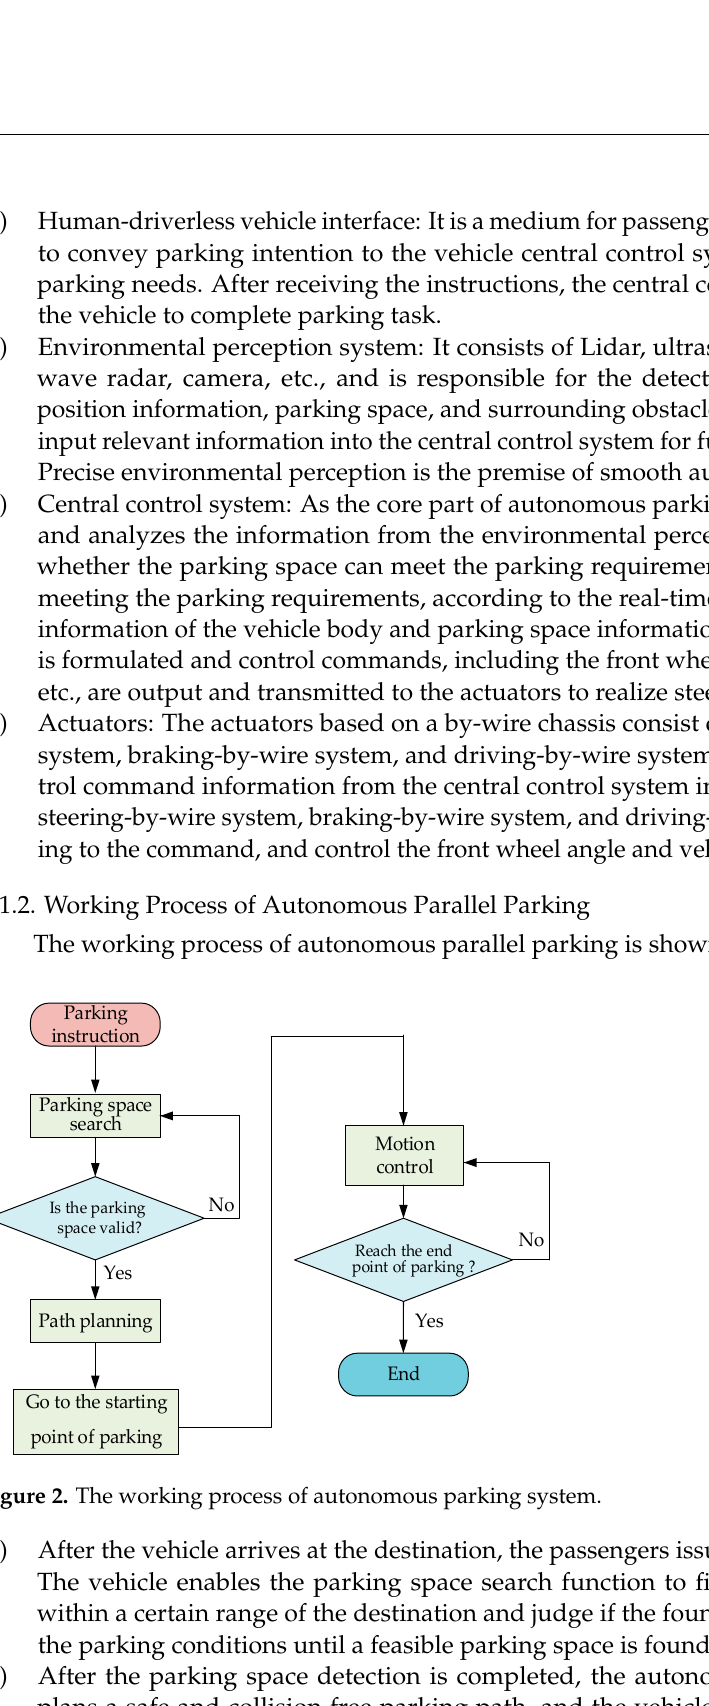
Figure 1. Composition of autonomous parking system.